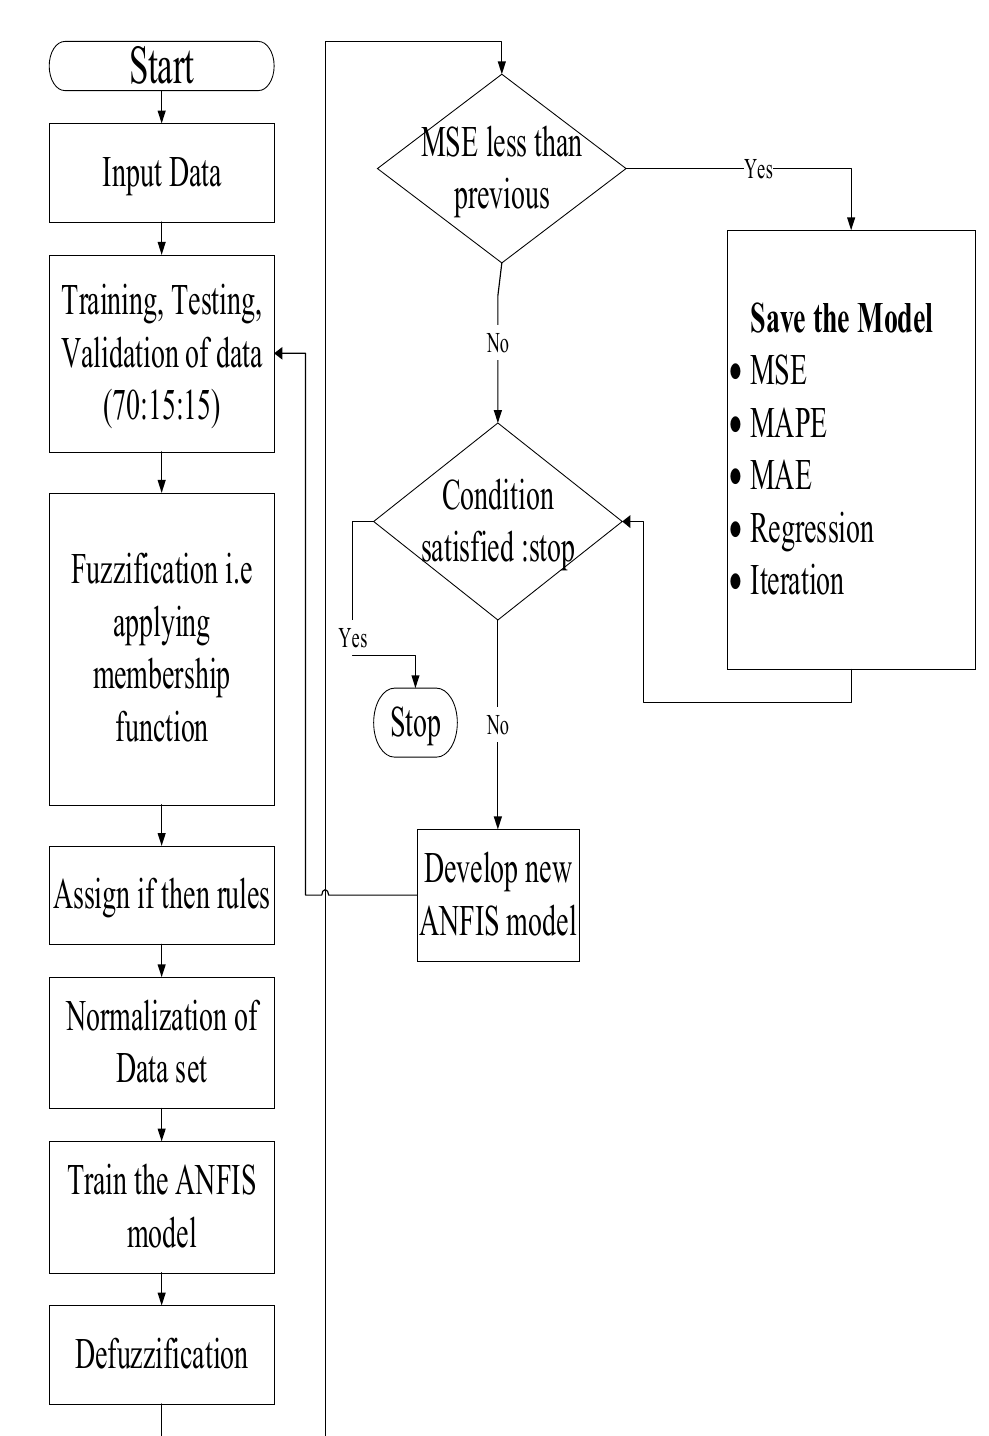
Figure 8. Training flow sheet for ANFIS model.